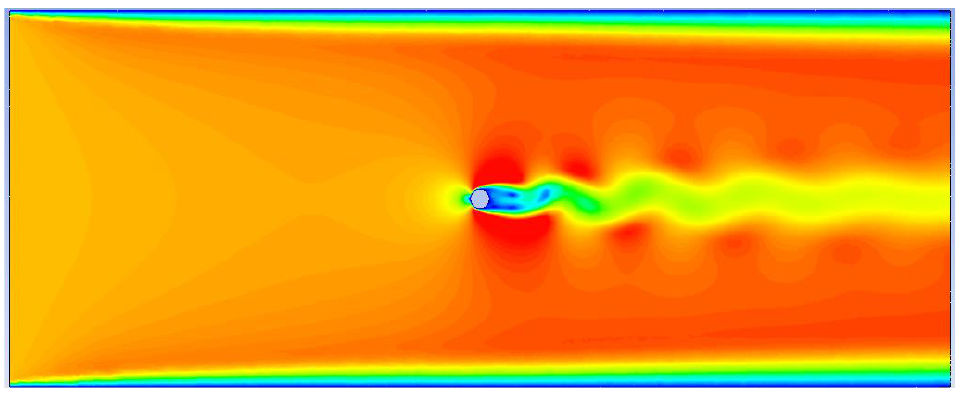
Figure 2. Kalman vortex.